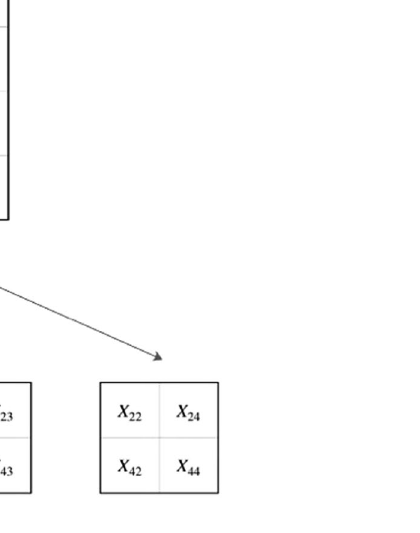
Figure 2. Sketch map of distributed pooling